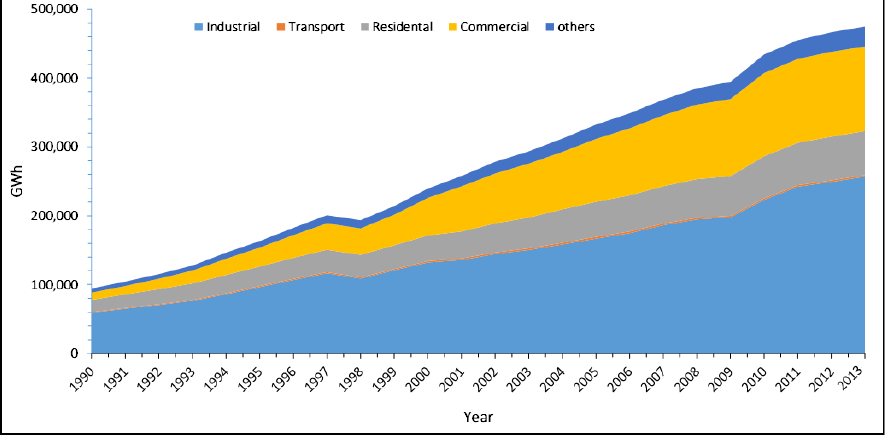
Figure 1. Sector-wise energy consumption in South Korea